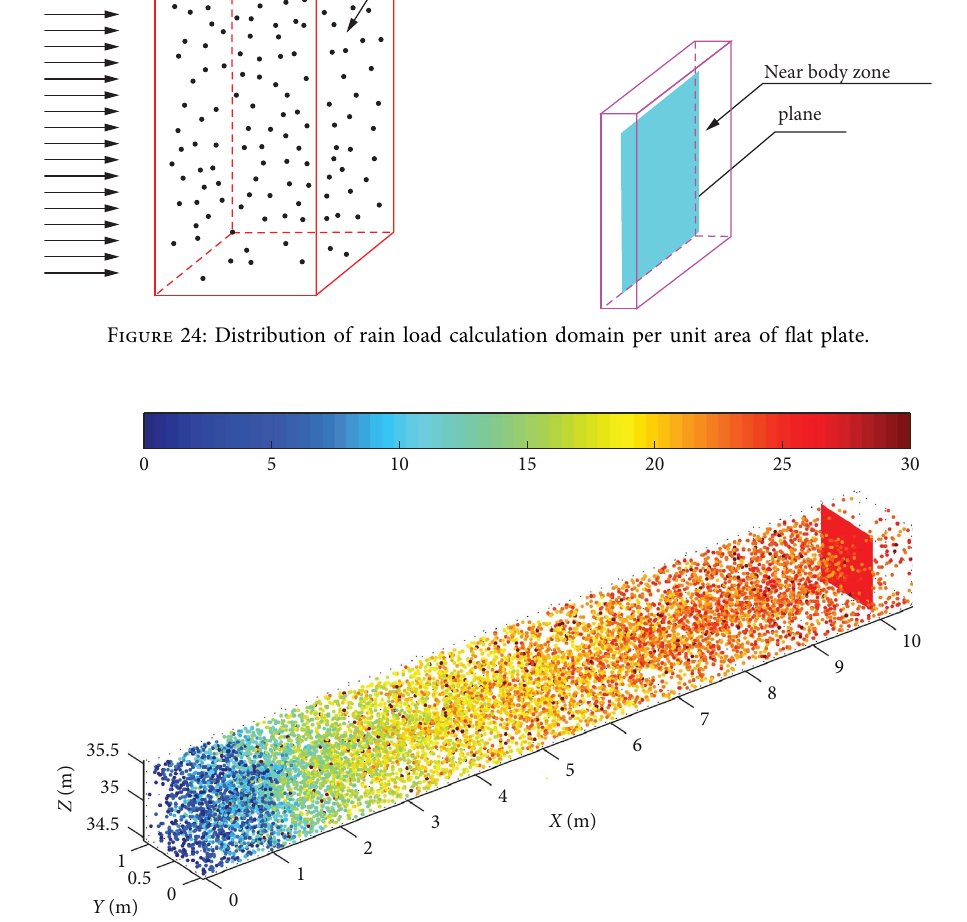
Figure 25: Distribution of rain feld